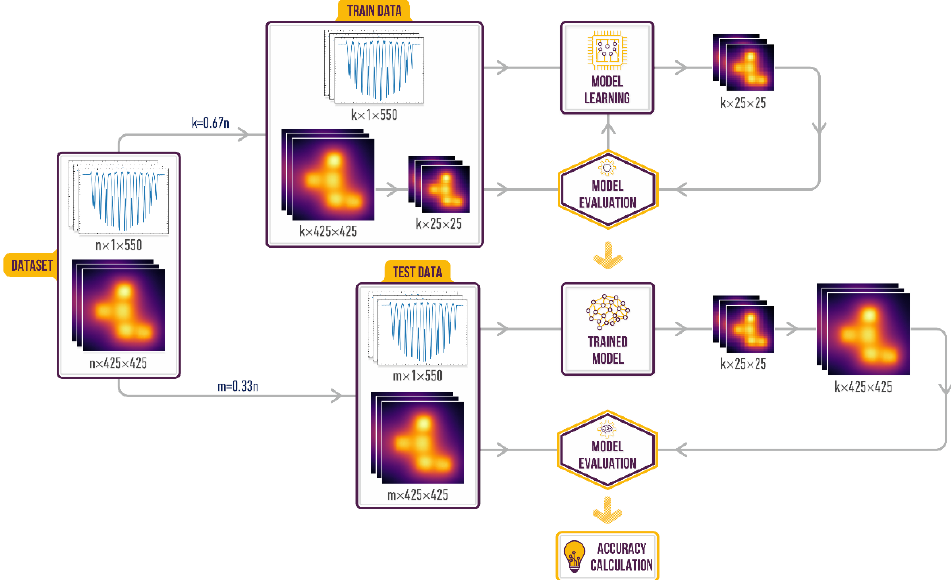
Figure 5. Functional diagram of the training procedure of the ML algorithm reconstructing 2D tem ‐ perature field of the sensor panel.